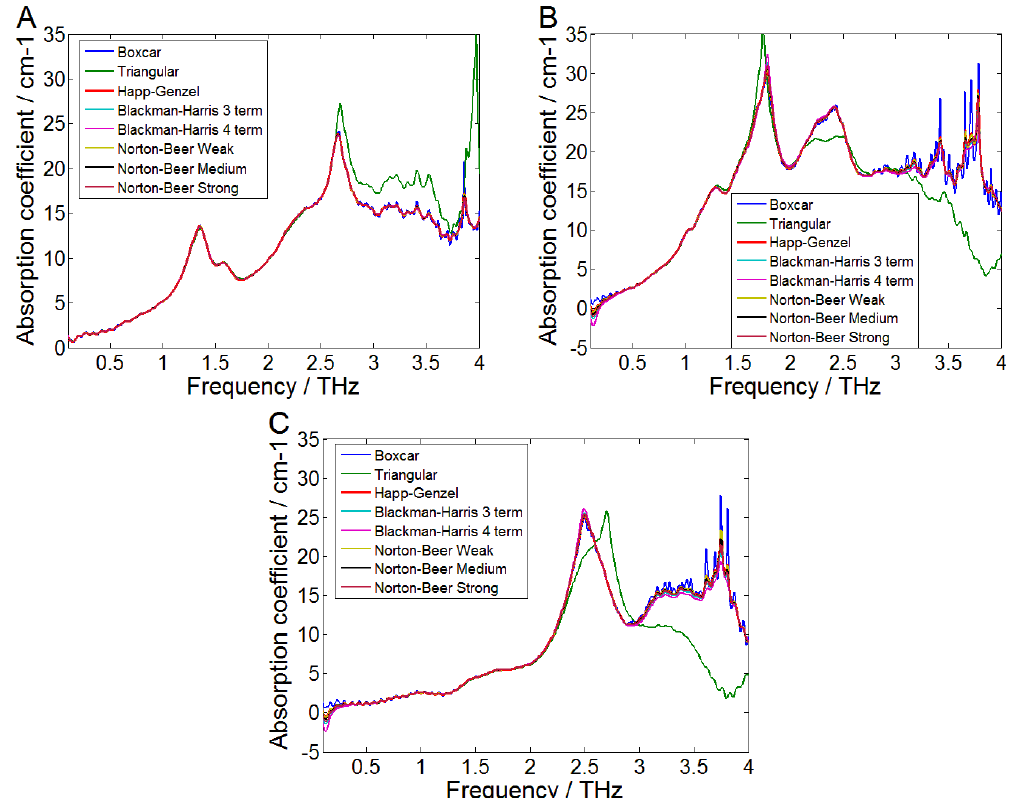
Figure 2. THz spectral processing of PGRs by window functions. ( A ) 2,4-D; ( B ) CPPU; ( C ) IAA.